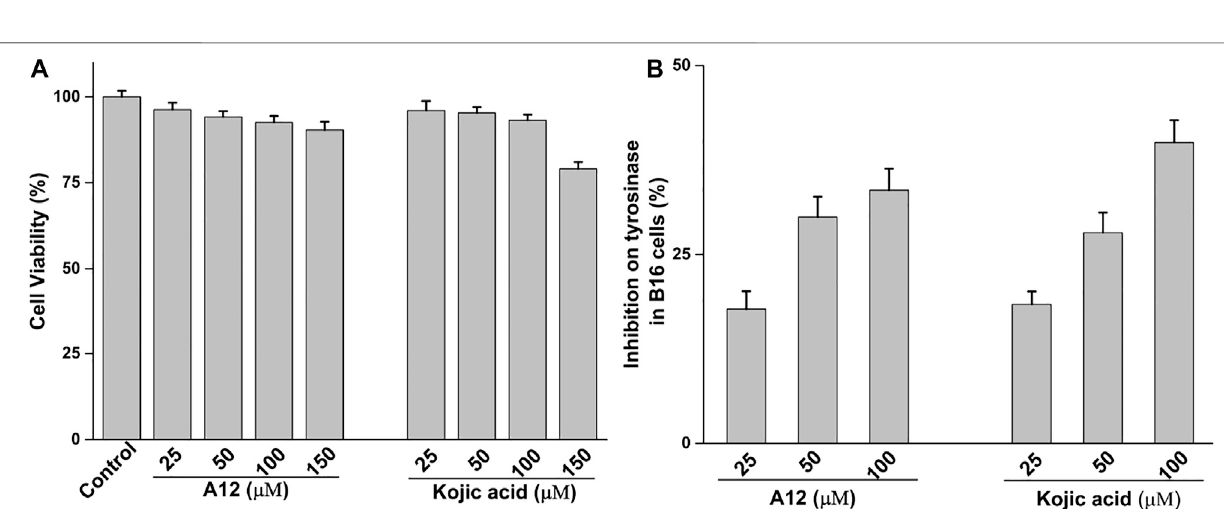
Frontiers in Chemistry |